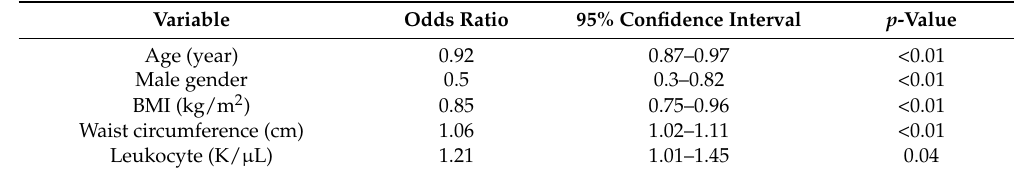
Table 3. Multivariate logistic regression modeling with annual eGFR change ≥ 1 mL/min/1.73 m 2 as the dependent